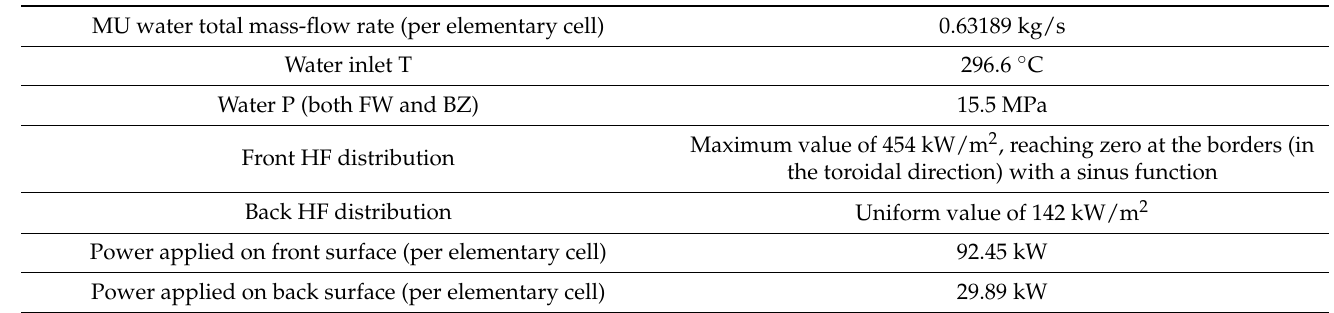
Table 5. Main boundary conditions used in the MU simulation